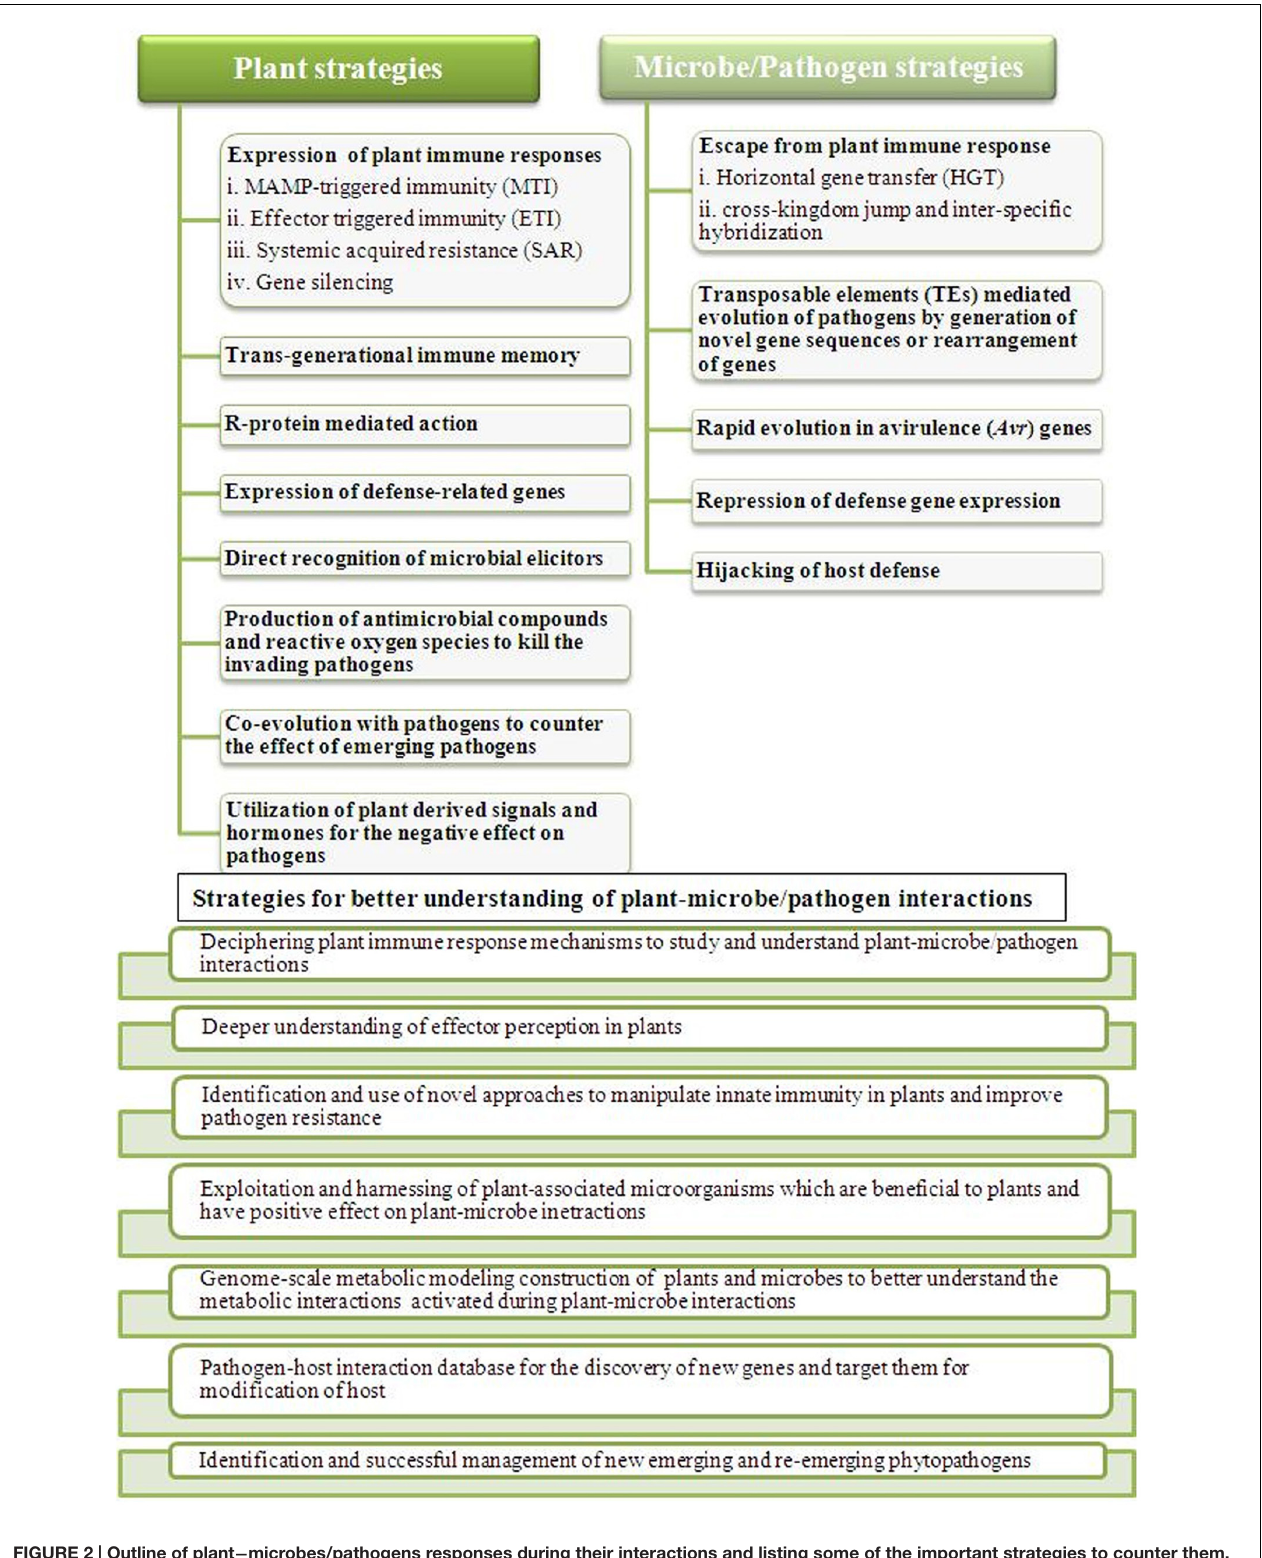
FIGURE 2 | Outline of plant − microbes/pathogens responses during their interactions and listing some of the important strategies to counter them. Plants as well as microbes/pathogens both faces challenges of each other during the battle and to better understand their interactions for effective outcome, different strategies needs to be implemented to address the problem of global food